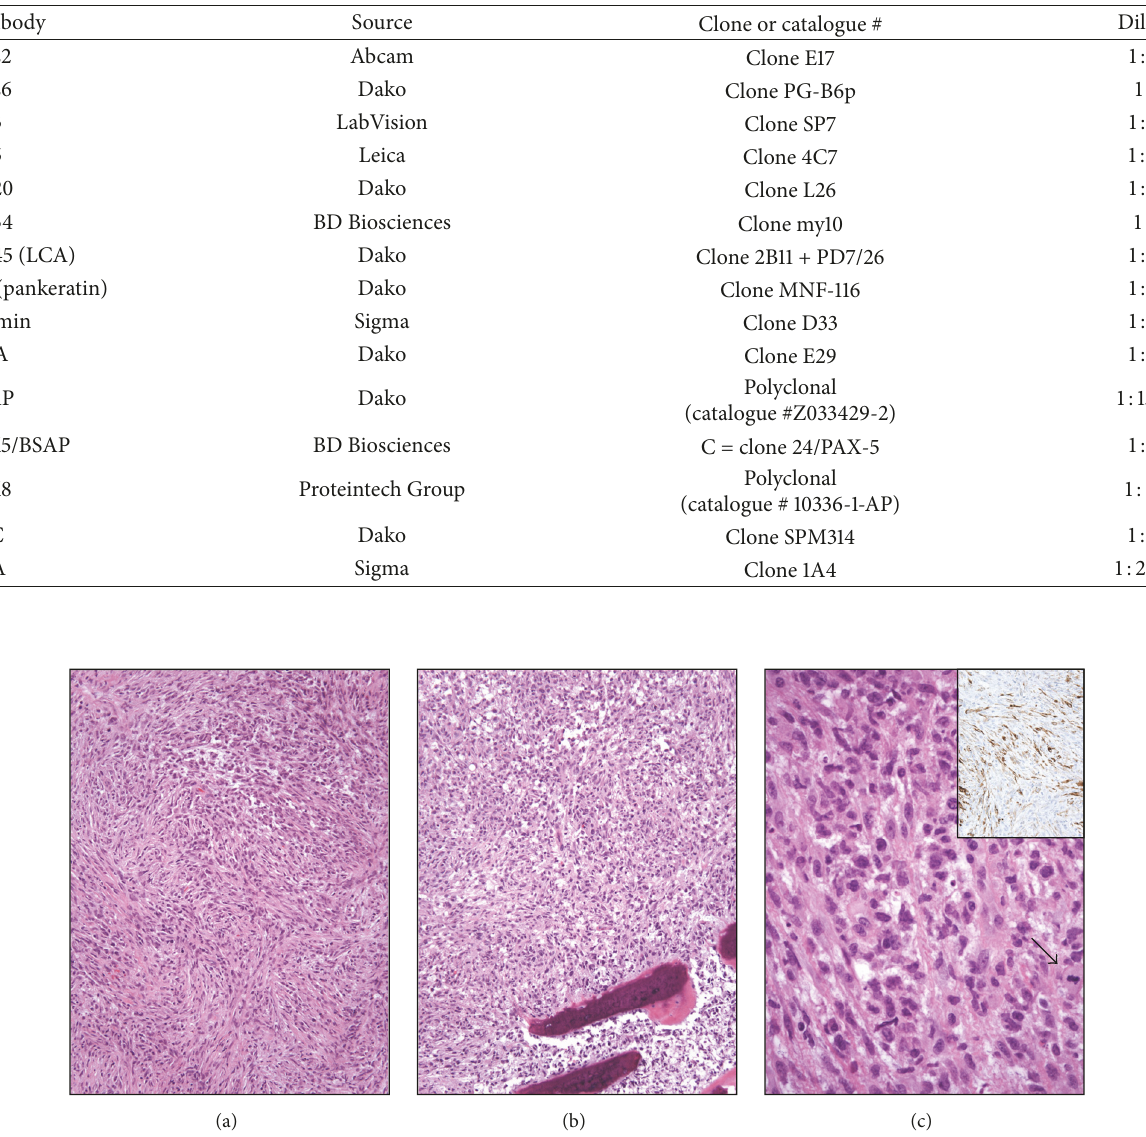
Table 1: Immunohistochemistry: sources, clones, and dilutions.